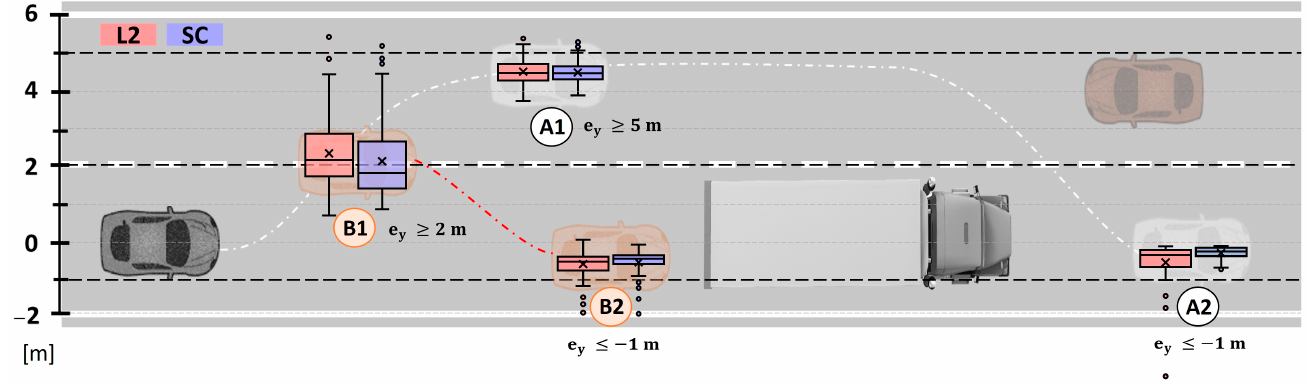
Figure 11. Boxplot analysis of the road-departure events. Two events are detailed: A-events related to those overtaking maneuvers finished, and B-events which are of those overtaking maneuvers aborted.